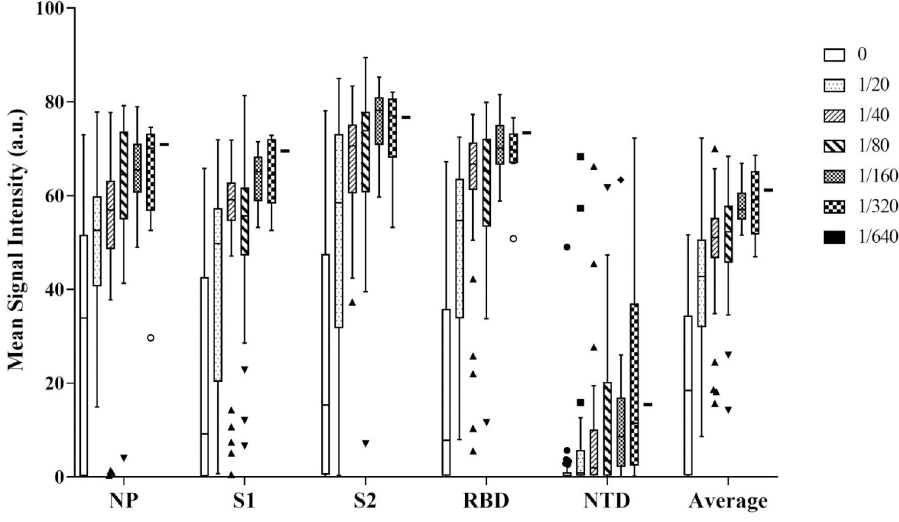
Fig 4. Correlation of the different IgG responses with serum neutralization titers. IgGs responses are based on the MSI in arbitrary units (a.u.) considered individually, or altogether (average). Neutralizing antibody titers are based on the serum dilution factor to neutralize 90% of infected